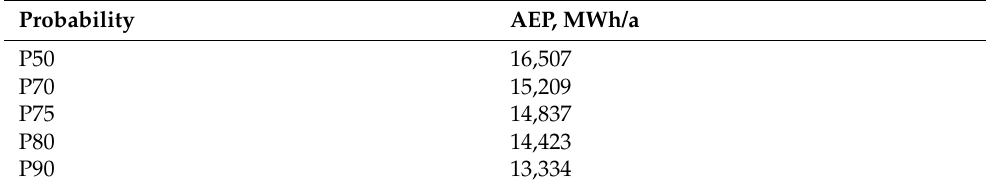
Table 3. AEP probability